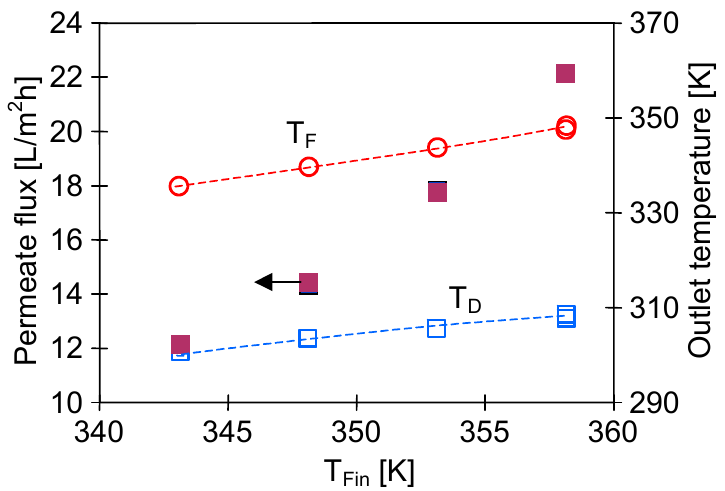
Figure 17. The influence of feed temperature on the permeate flux and feed / distillate outlet temperature. Capillary module CMD1. T Din = 290 K, v F = 0.8 m / s, v D = 0.4 m / s.